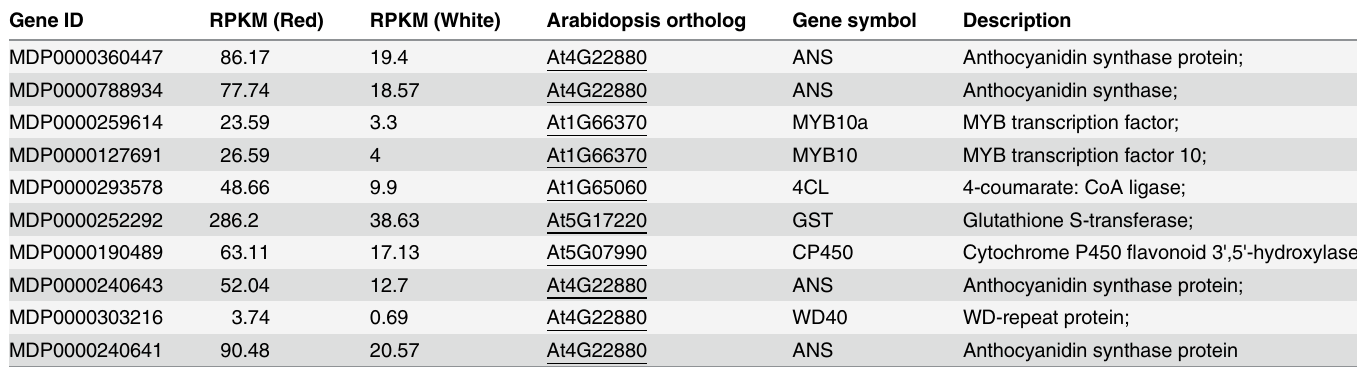
Table 4. Up-regulated genes involved in both the flavonoid biosynthetic process and stress response in red-fleshed apples. Gene ID RPKM